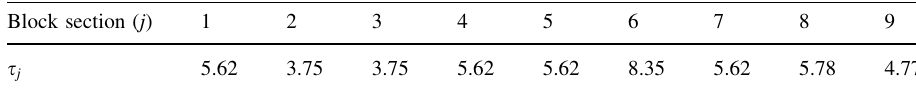
Table 3 Train pure running time between two consecutive stations (minutes)